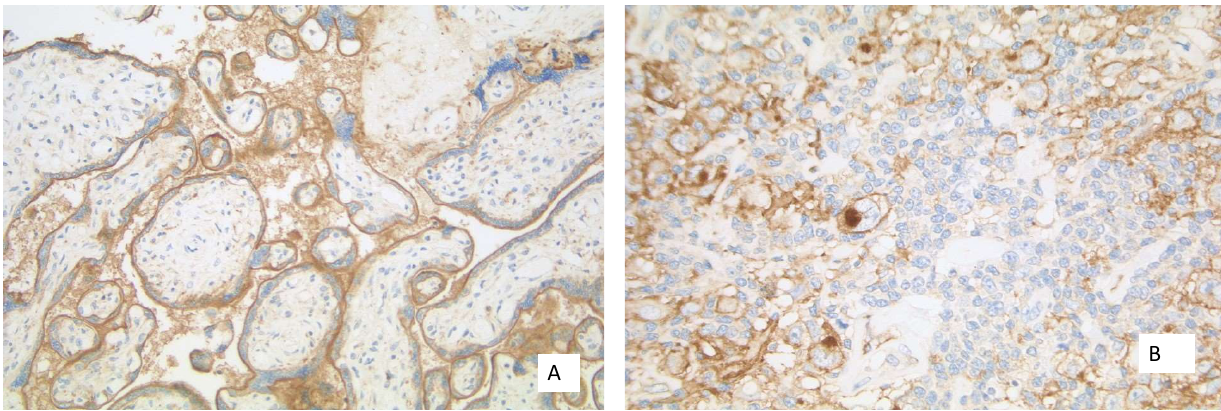
Figure 7. ( A ) Placental tissue with membranous staining of the syncytiotrophoblast (40 × Obj.); ( B ) Hodgkin cells with expression of PD-L1 at the membrane and Golgi region (40 ×